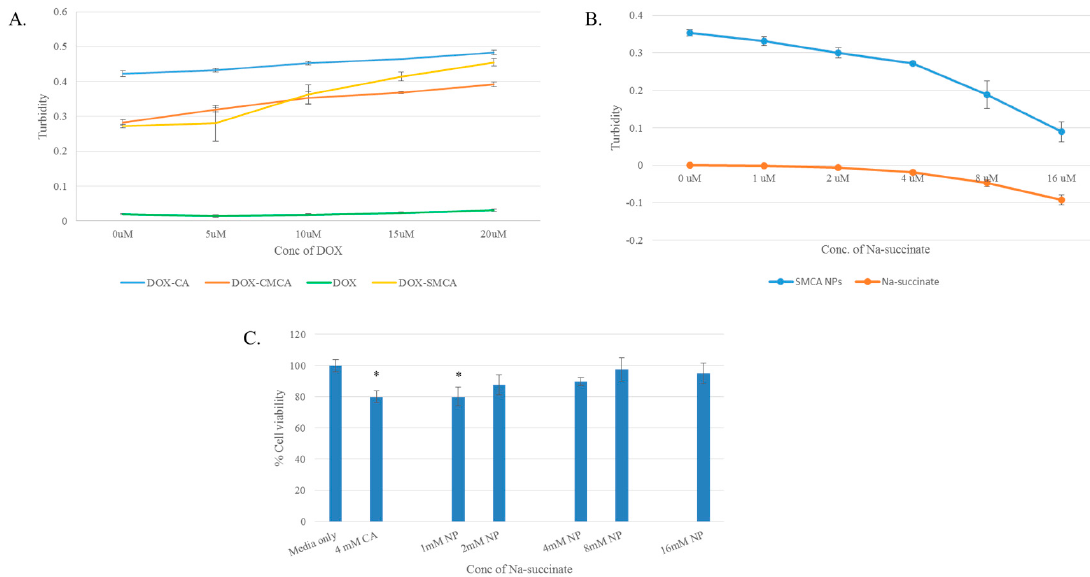
Figure 1. ( A ) Turbidity of DOX, DOX-loaded CA, DOX-loaded CMCA and DOX-loaded SMCA NPs measured using different concentrations (0 µM to 20 µM) of DOX; ( B ) turbidity of SMCA NPs measured using different concentrations (0 mM to 16 mM) of sodium succinate; ( C ) cell viability assessment by MTT assay after 48 h incubation of the CMCA NPs with MCF-7 cell line. Values were significant (*) at p -value 0.01 to 0.05 vs. untreated cell at CI of 95%. DOX: Doxorubicin, CA: Carbonate apatite, CMCA: Citrate-modified carbonate apatite, SMCA: Succinate-modified carbonate apatite, MTT: 3-(4,5-Dimethylthiazol-2-yl)-2,5-Diphenyltetrazolium Bromide and CI = Confidence interval.